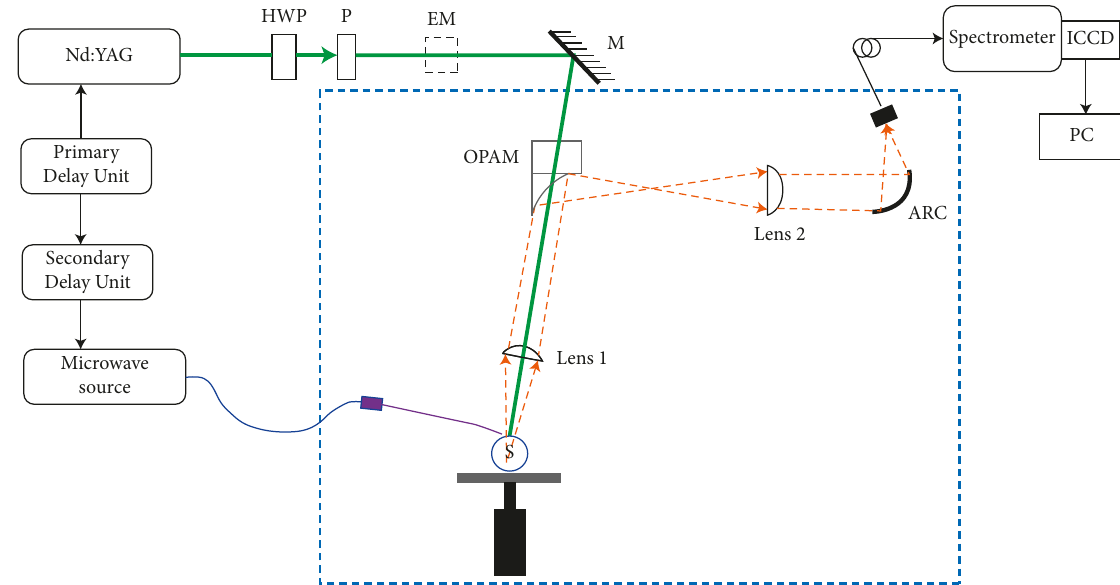
Figure 4: Schematic of the experimental setup of microwave-assisted LIBS (adapted from